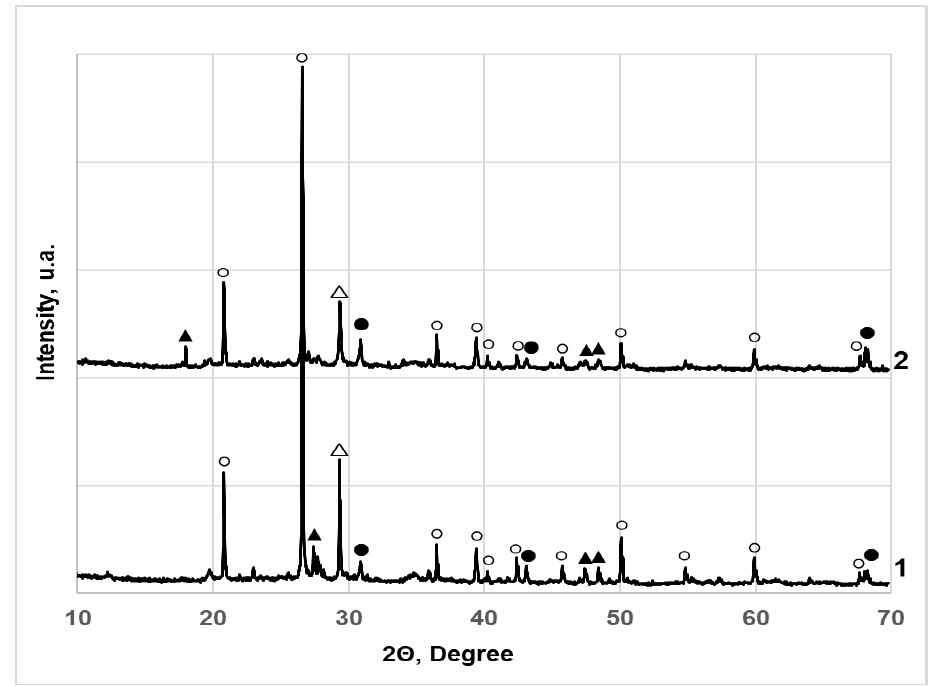
Figure 10. X-ray diffractograms of clay SCS samples with Cr (VI) 3000 mg/kg and different amounts of Carbofill E: 1–10% 2–20%. The peaks were identified and assigned as follows: ( ) quartz ( hexagonal ) SiO 2 83–539; ( ▲ ) wollastonite 2M ( monoclinic ) CaSiO 3 84–655; ( ) wollastonite 2M ( monoclinic ) Ca 3 (Si 3 O 9 ) 76–1846; ( ) calcium chromium oxide ( hexagonal ) Ca 5 (CrO 4 ) 3 O 0,5 38–294.